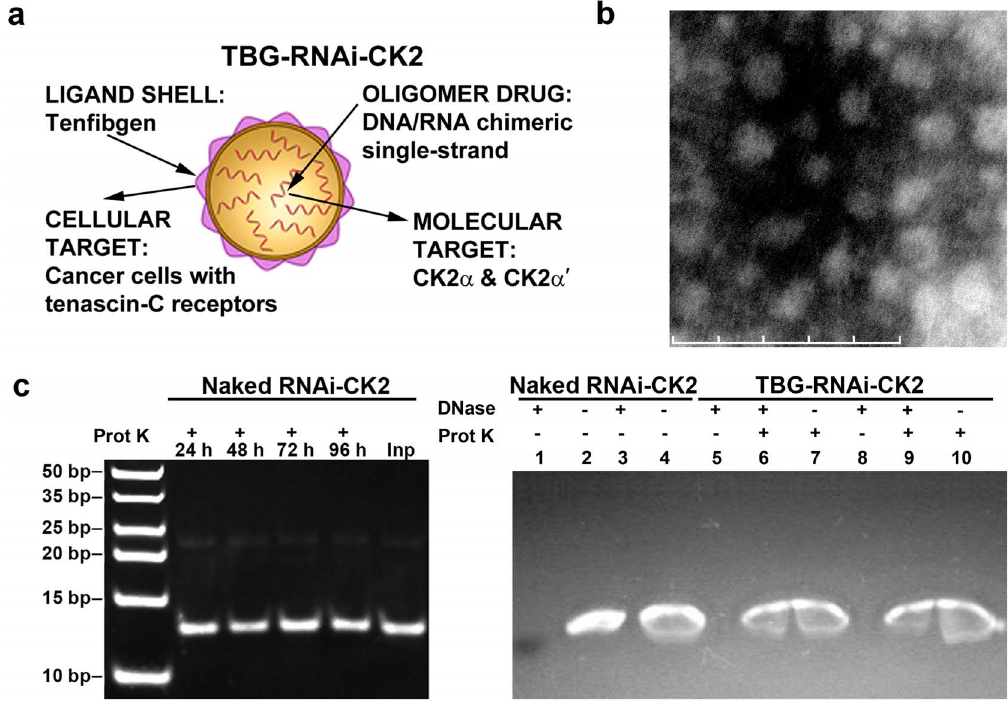
Figure 1. Nanocapsule design, morphology, cargo stability, and cargo protection. ( a ) Cartoon depiction of nanocapsule design. ( b ) Transmission electron micrograph of s50-TBG-RNAi-CK2 nanocapsules for in vivo studies. Magnification 230,000 6 . Scale bar 100 nm. ( c ) Left panel: Naked RNAi-CK2 oligomer was digested with proteinase K for 24 to 96 h. Inp, undigested input oligomer. Right panel: Naked and s50-TBG encapsulated RNAi-CK2 oligomers were digested with DNase followed by proteinase K as indicated above the panel. Lanes 1 & 2, naked RNAi-CK2; 3 & 4, naked RNAi-CK2 with TBG-sugar nanocapsules included in the digestion; 5 - 7, in vitro use formulation of s50-TBG-RNAi-CK2; 8 – 10, in vivo use formulation of